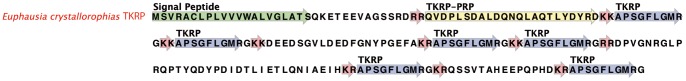
Complete protein sequence of the pre-pro-peptide containing the Tachykinins of E. crystallorophias.The 6 identical examples of Tachykinin are highlighted in blue. The signal peptide is highlighted in green and the potential bibasic cleavage sites, in red. The latter delimit the 4 potential PRPs. The PRP highlighted in yellow was characterised by mass spectrometry.